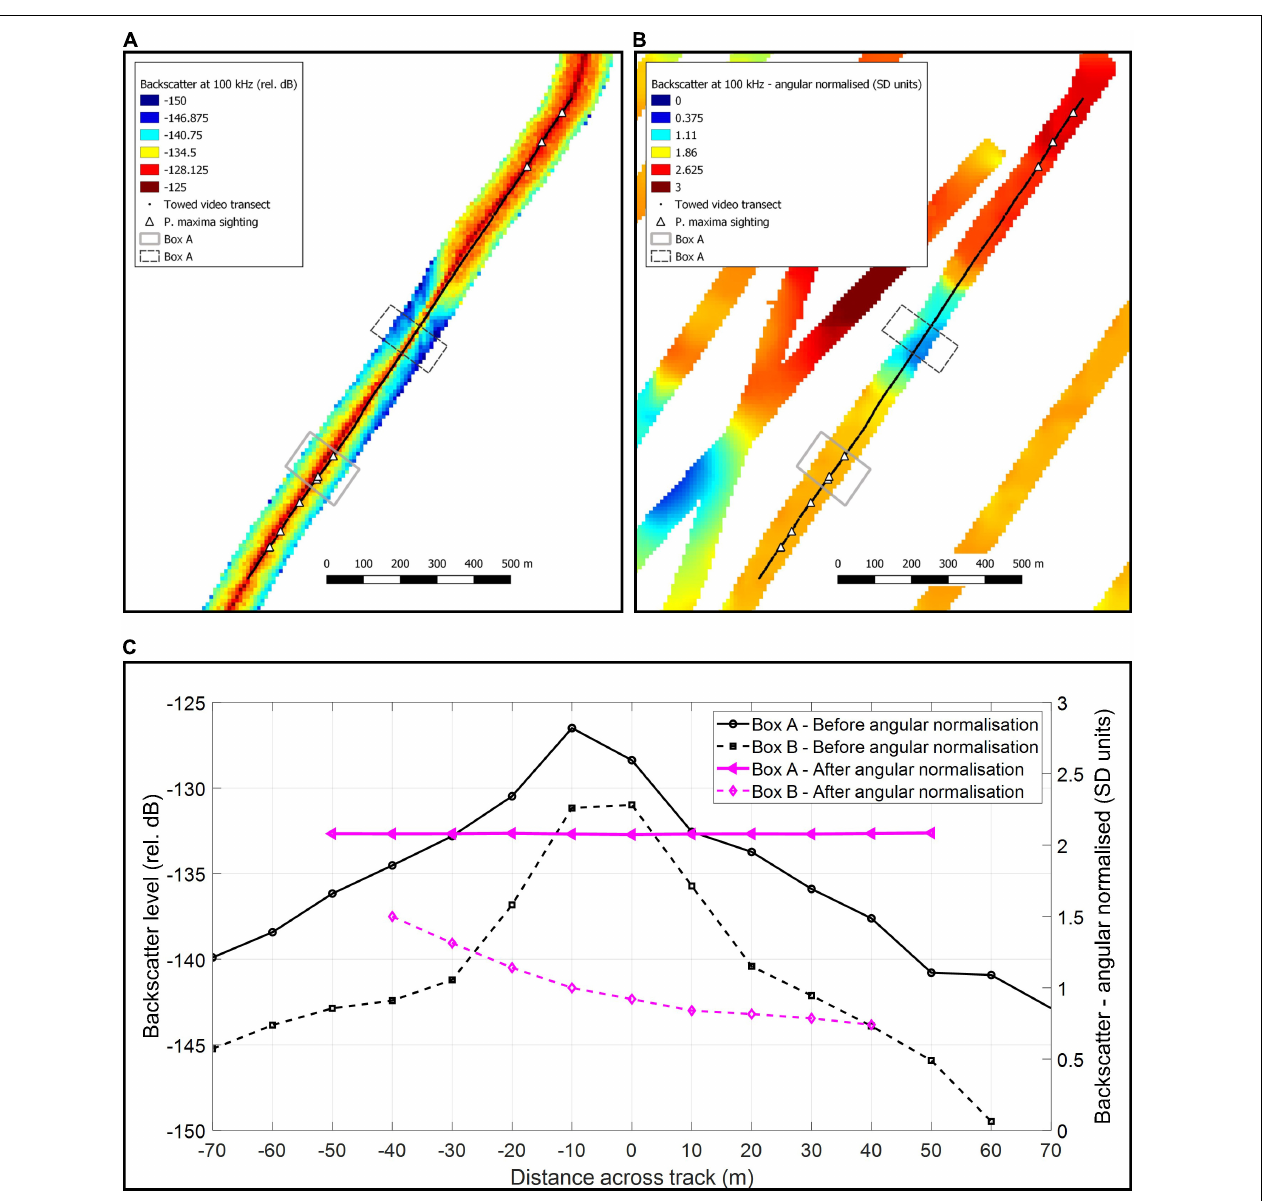
FIGURE 2 | Multibeam backscatter at 100 kHz gridded to 10 m and a towed video transect showing detections of Pinctada maxima , where: (A) is before and (B) after the angular normalisation has been applied to the backscatter data, and (C) the mean across-track backscatter from Boxes (A,B) .